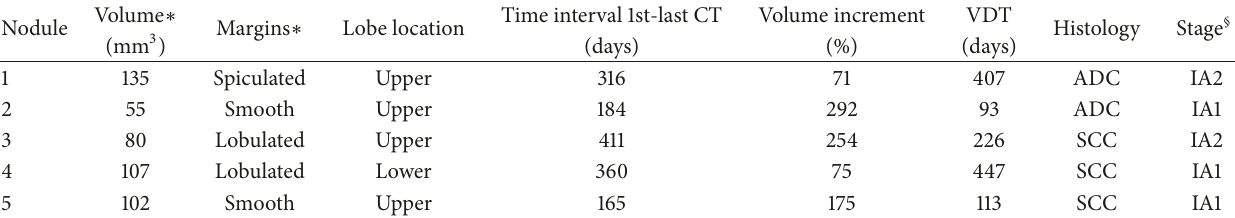
Table 4: Characteristics and histological features of the malignant nodules.